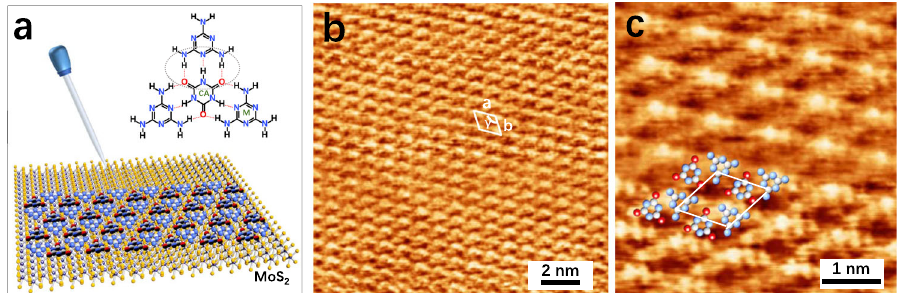
Fig. 2 Supramolecular network of co-assembled CA·M monolayer onto monolayer MoS 2 . a Schematic representation of the network formation, and the molecular structure of CA·M formed through hydrogen bonding between on monolayer MoS 2 . b , c Scanning tunneling microscope height image of co- assembled network adsorbed onto MoS 2 surface, and its unit cell is denoted by a white rhombus. Unit cell parameters, i.e., vectors a = b = 0.96 ± 0.02 nm, and the angle between them γ = 120 ± 2° ( b ) survey ( c ) zoom-in with proposed molecular packing motif of CA·M. Tunneling parameters: b tip bias voltage ( V t ) = − 930 mV, average tunneling current ( I t ) = 60 pA; c V t = − 950 mV, I t = 60